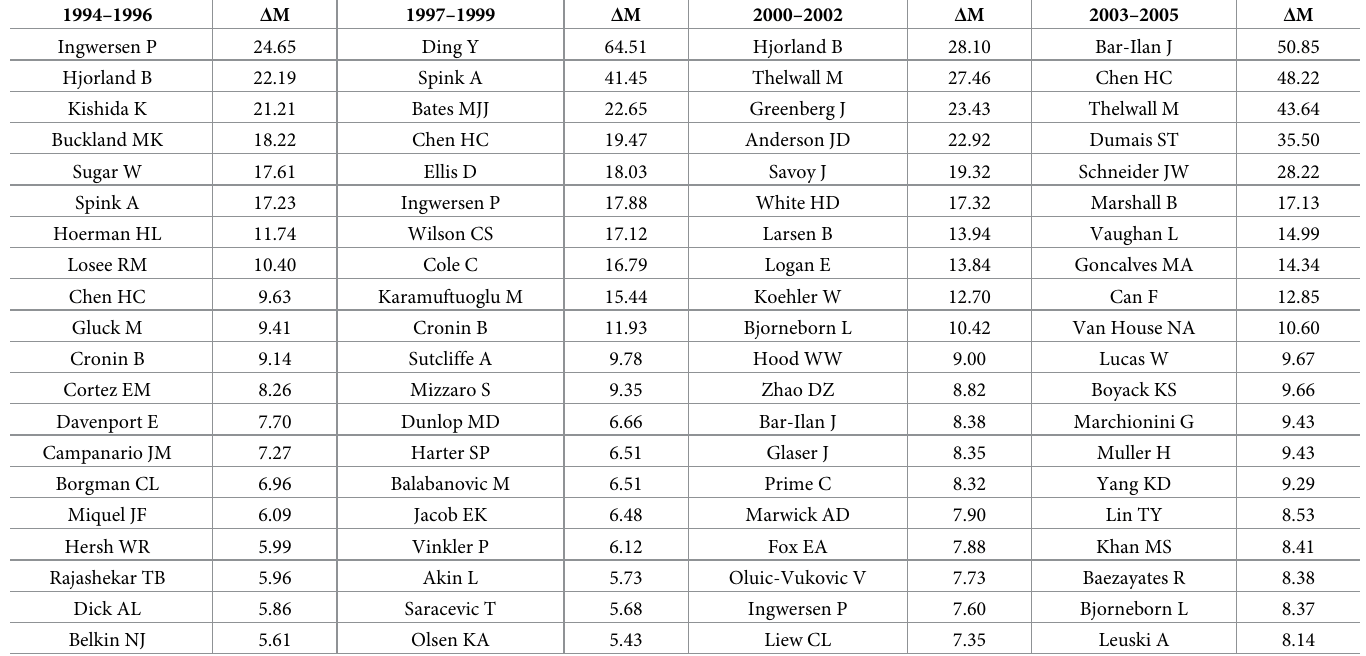
Table 7. Top 20 researchers with the largest Δ M in each of the 3-year time interval